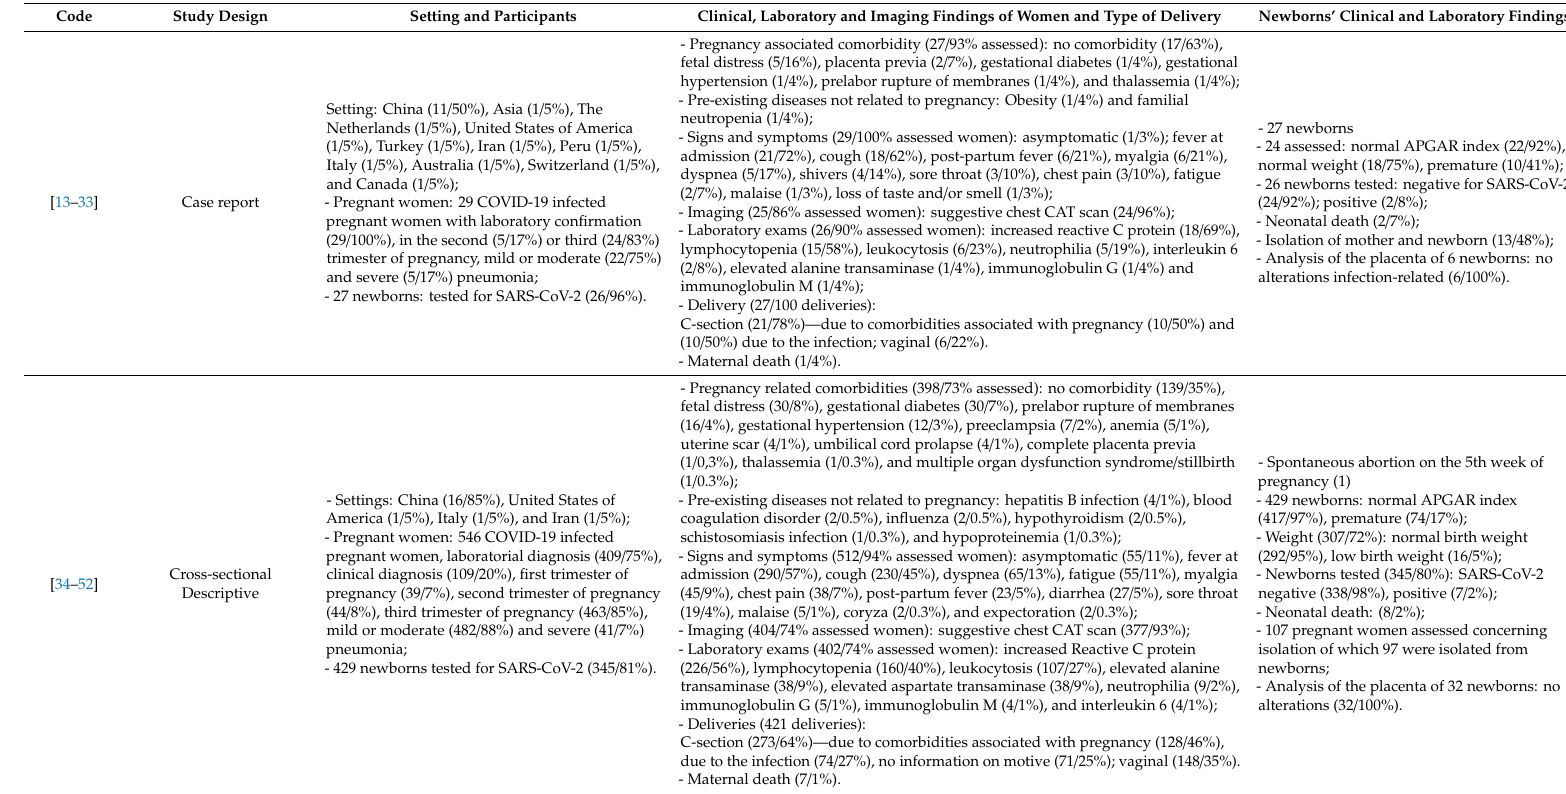
Table 2. Characteristics of included studies: study design, settings and participants, clinical, laboratory, and imaging findings of women, and type of delivery and clinical and laboratory findings of